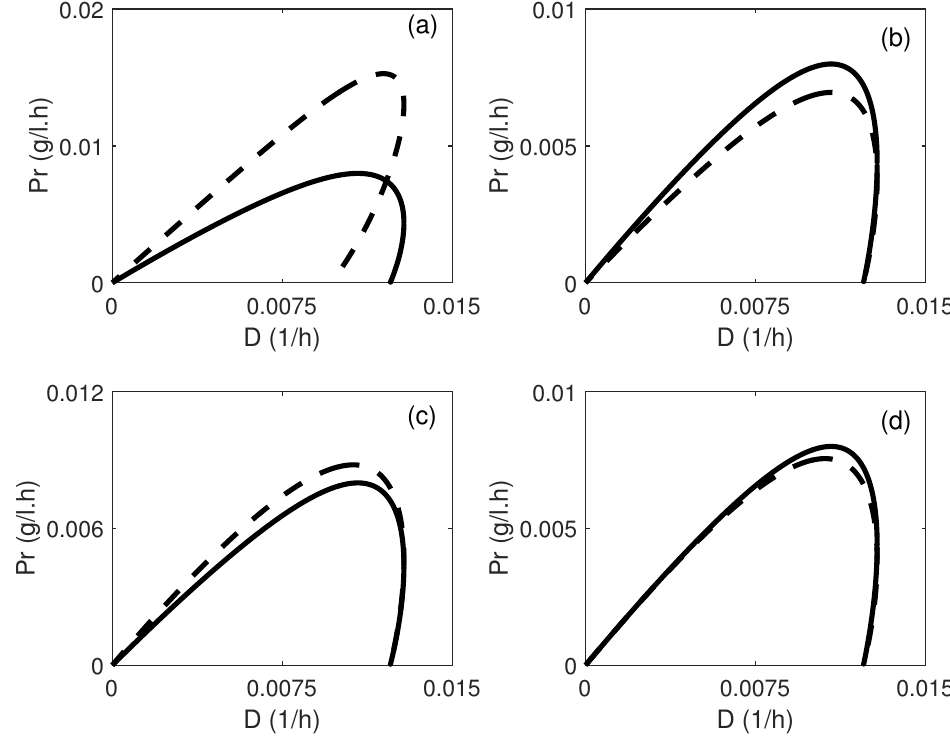
Figure 5. Effect on productivity of increase in values of model parameters. Effect of increase of ( a ) S f ; ( b ) q m ; ( c ) q s , and ( d ) q i . Solid line corresponds to nominal values of Table 1. Dashed line (- -) corresponds to the increase in the value of the